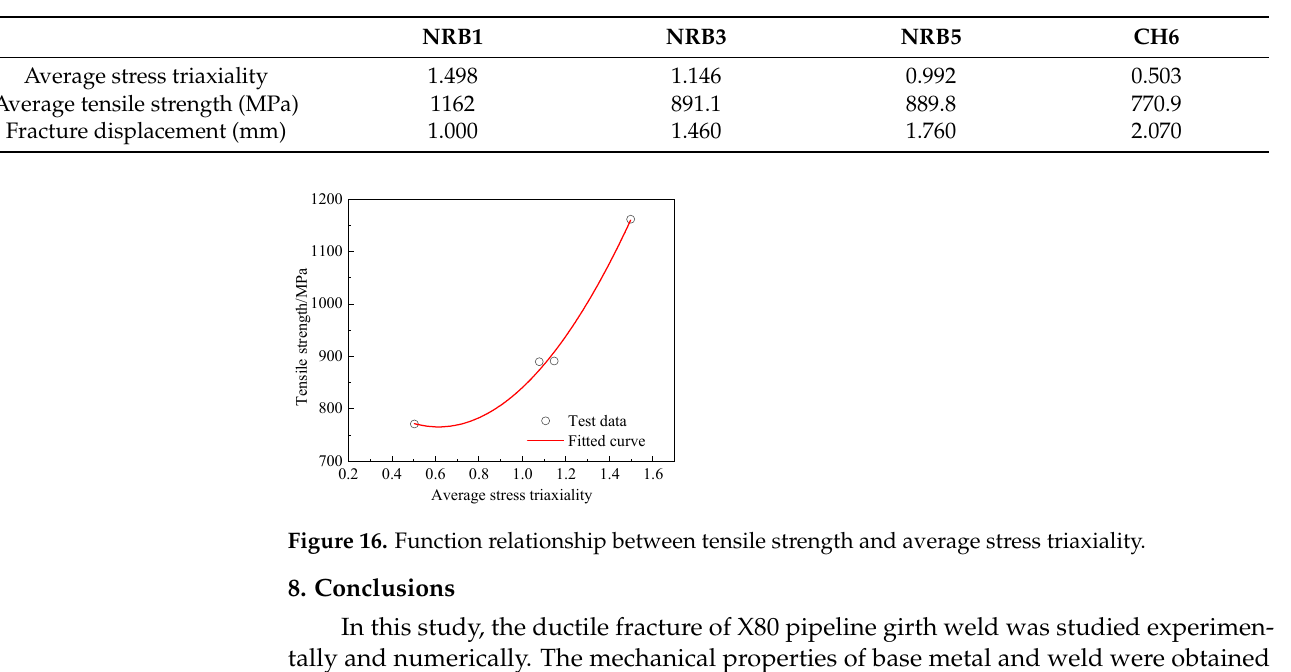
Figure 15. Comparison of experimental and simulated fracture morphology: ( a ) CH6, ( b ) FS, ( c ) NRB1, ( d ) NRB3, and ( e ) NRB5.